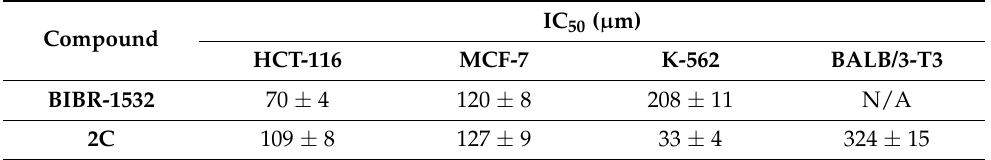
Table 3. IC 50 of 2C against HCT-116, MCF-7, K-562, and BALB/3-T3 cell lines. Values were calculated by plotting the percentage viability versus concentration on a logarithmic graph and are expressed as the mean ± SD of three separate experiments conducted in triplicate. IC 50 ( µ Compound